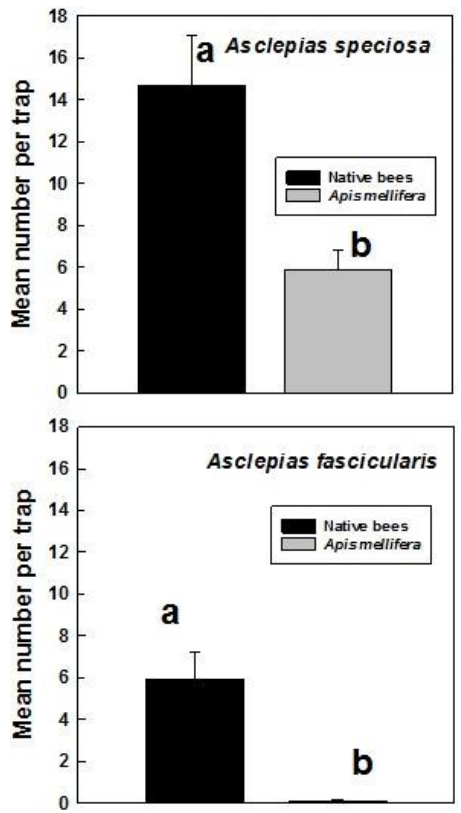
Figure 4. Mean (±SE) number of native bees and honey bees ( Apis mellifera ) trapped on flowering A. speciosa and A. fascicularis during 2010–2013 ( speciosa ) and 2012–2014 ( fascicularis ). Bars denoted by different letter are significantly different ( p < 0.001).